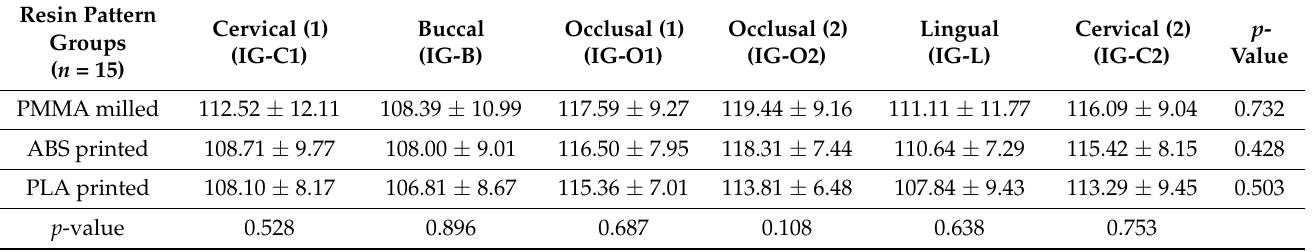
Table 4. Comparison of the internal gap on all six locations among the three different resin patterns in buccolingual cross-section in